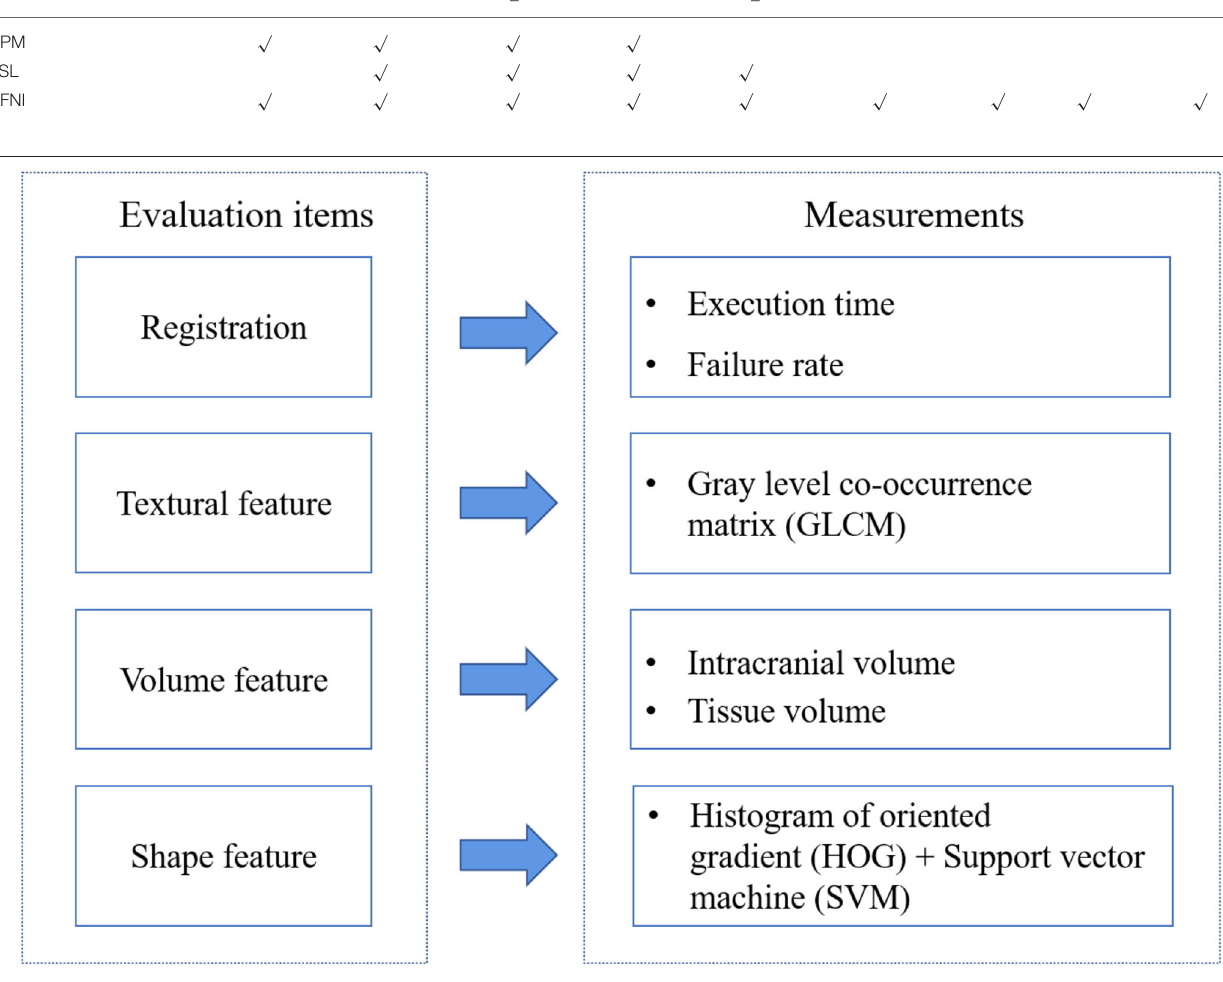
FIGURE 1 | Comparison